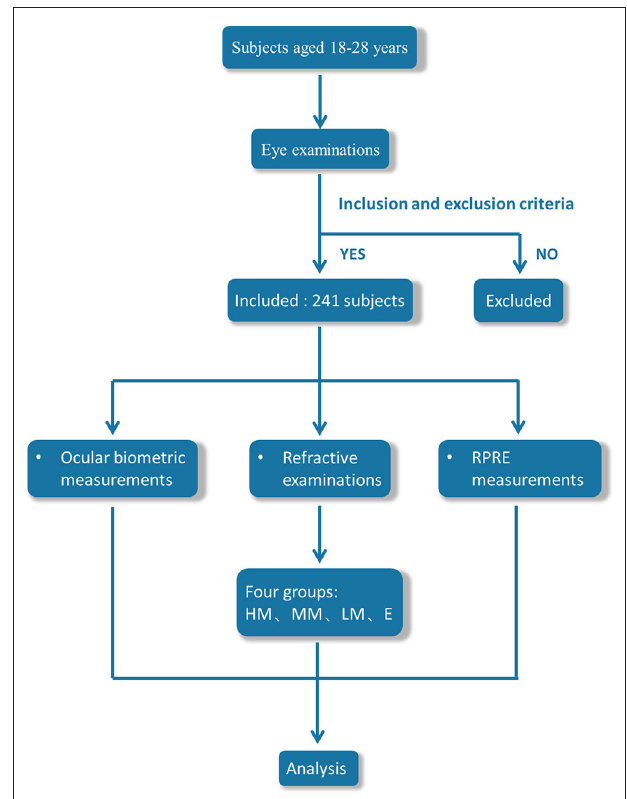
FIGURE 1 | Flowchart of experimental